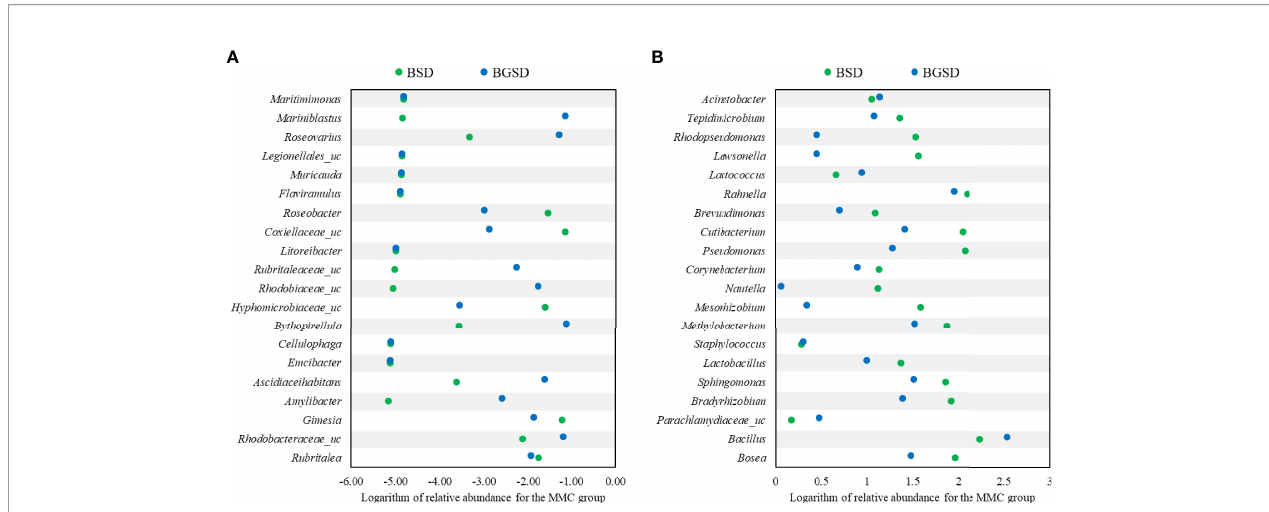
FIGURE 6 | Comparison of the relative abundance of decreased (A) or increased (B) OTUs compared to the control group. BSD: 1 × 10 8 CFU g − 1 Bacillus sp. PM8313, and BGSD: BSD + 0.1% b